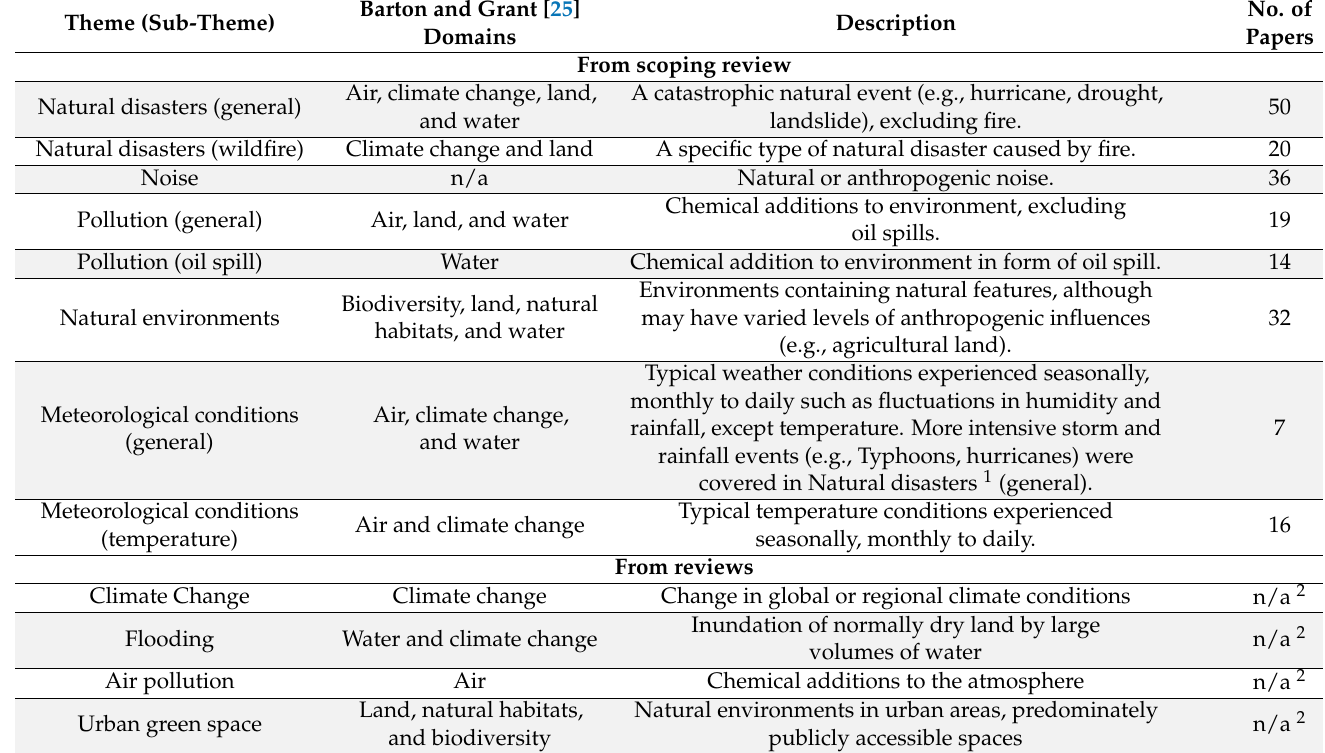
Table 3. Themes within which environmental science contributes to mental health